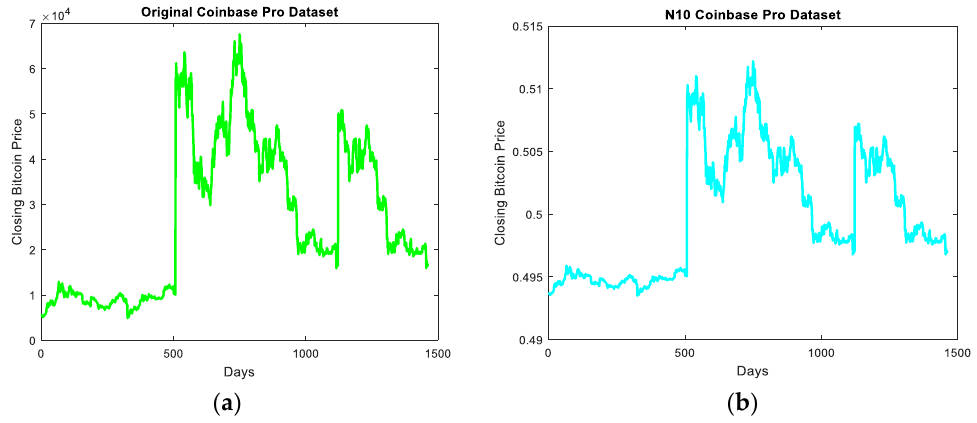
Figure 5. ( a ) Original Coinbase Pro dataset of closing Bitcoin price in US dollars ( b ) Normalized Coinbase Pro dataset using the proposed dual normalization.